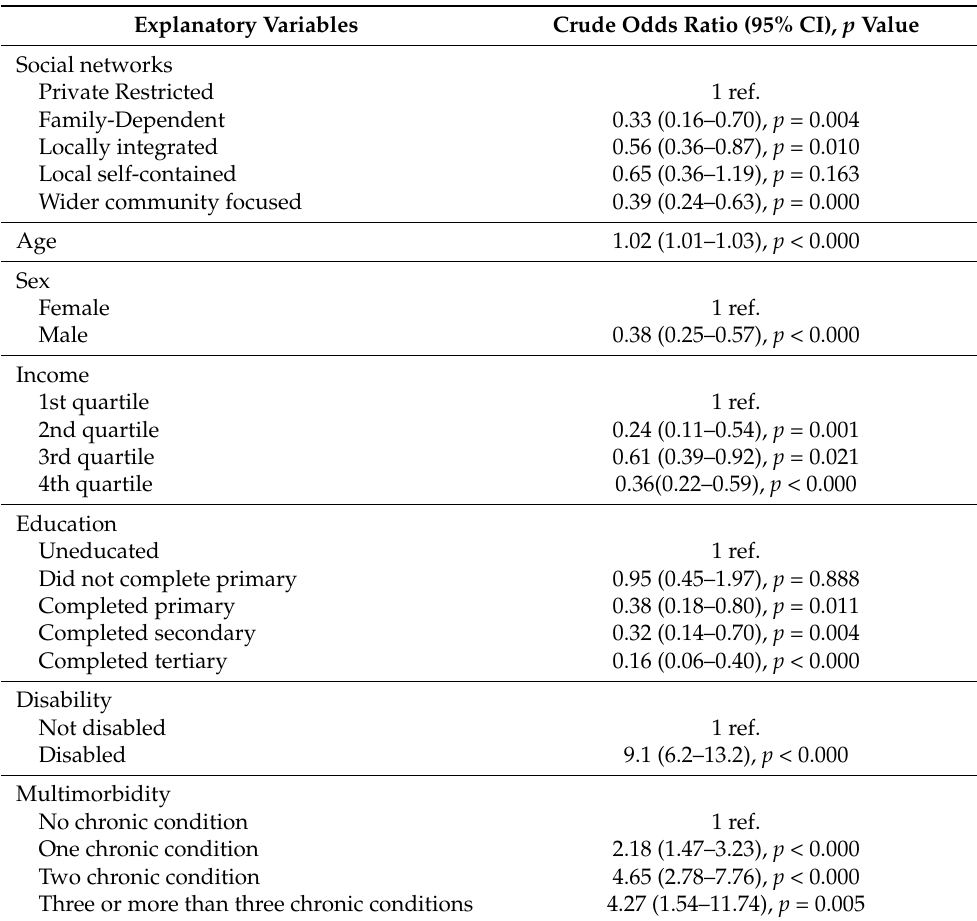
Table 2. Association between social network types and depression.